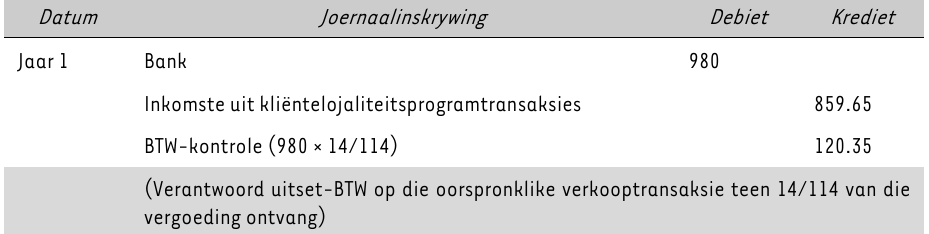
TABEL 6: Algemene joernaalinskrywings van maatskappy A Datum